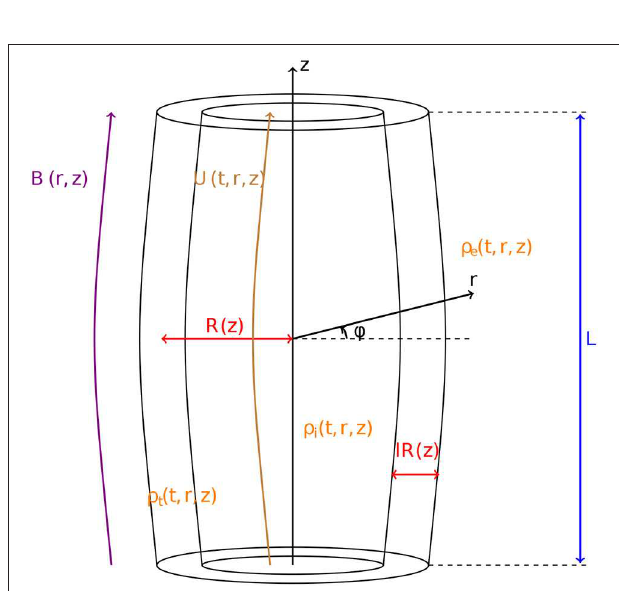
FIGURE 5 | Equilibrium configuration of theoretical model. The black lines with labels r , φ , and z correspond to the cylindrical polar coordinates system. B( r , z ) is the background magnetic field, U( t , r , z ) is the background flow parallel to the magnetic field, R ( z ) is the radius of the tube, l is a constant determining the thickness of the transitional layer, ρ i ( t , r , z ) is the density in the internal region, ρ e ( t , r , z ) is the density in external region, ρ t ( t , r , z ) is the monotonically decaying density in the transitional layer from ρ i ( t , r , z ) to ρ e ( t , r , z ), L is the length of tube for the standing waves and the characteristic value of the wavelength for propagating